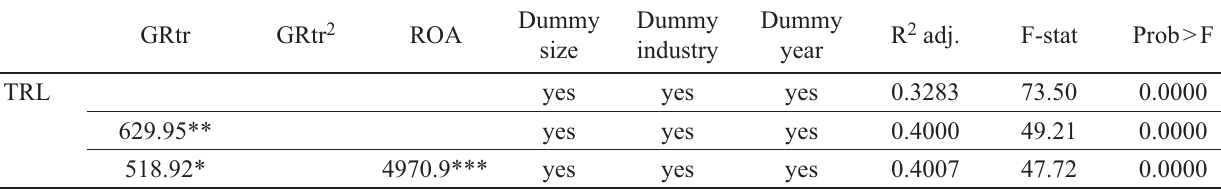
Table 5. Fixed effects models for the dependence of revenue per employee on the growth rate and control variables GRtr GRtr 2 ROA